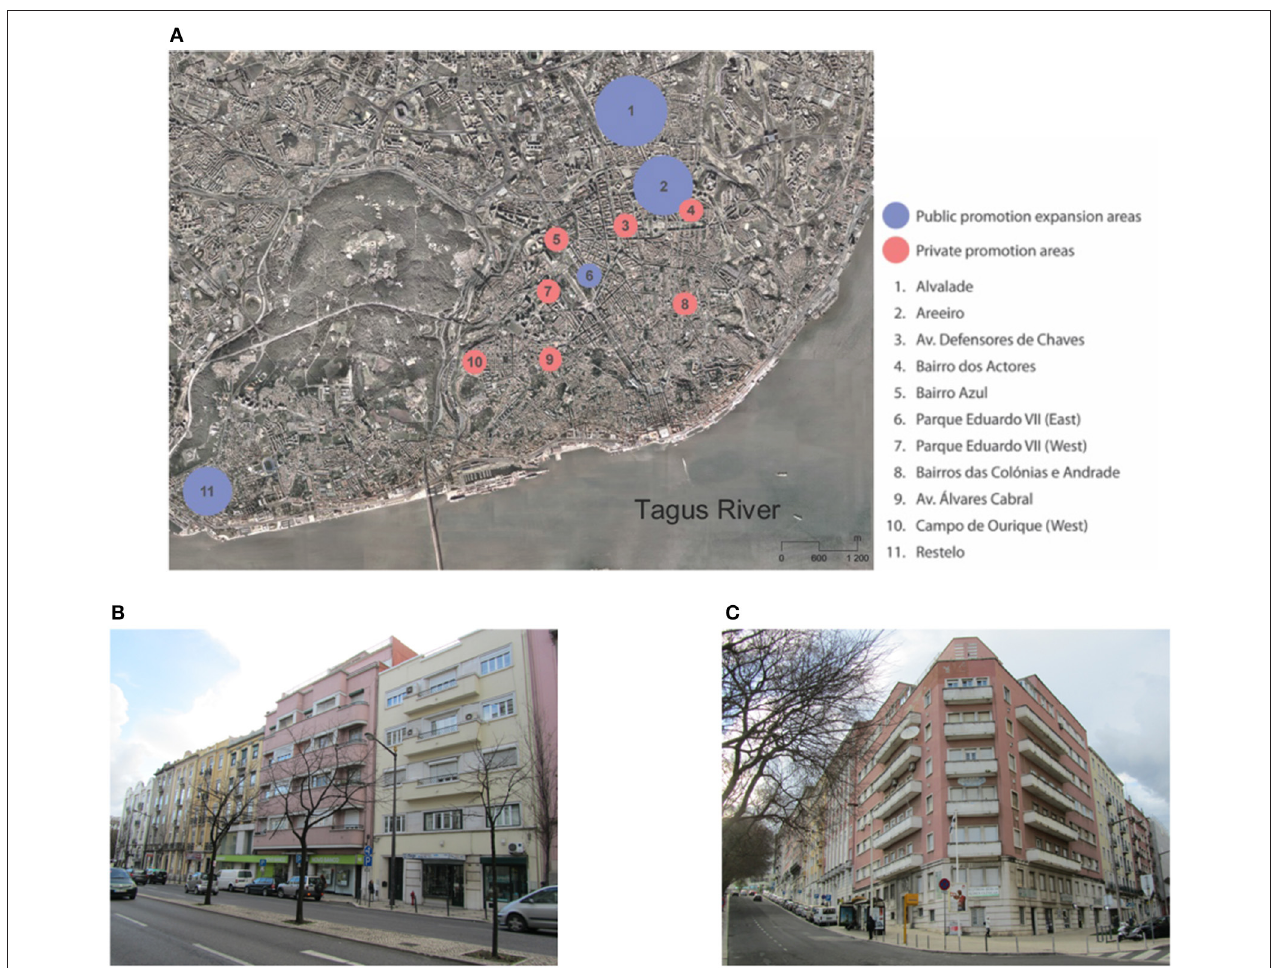
FIGURE 2 | Some of the mixed masonry RC apartment buildings and their insertion areas. (A) Location of the buildings. (B) “Déco” and modernist buildings and (C) “Nationalist” or “soft” modern image